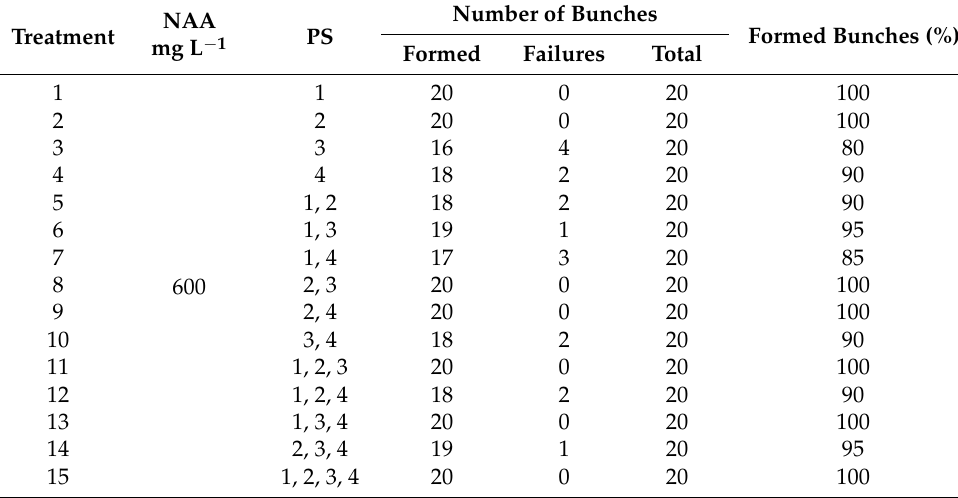
Table 4. Effect of multiple NAA applications on the proportion of bunches formed. Doses of different phenological stages (PS) to induce parthenocarpy in the OxG hybrids (Coari x La M é